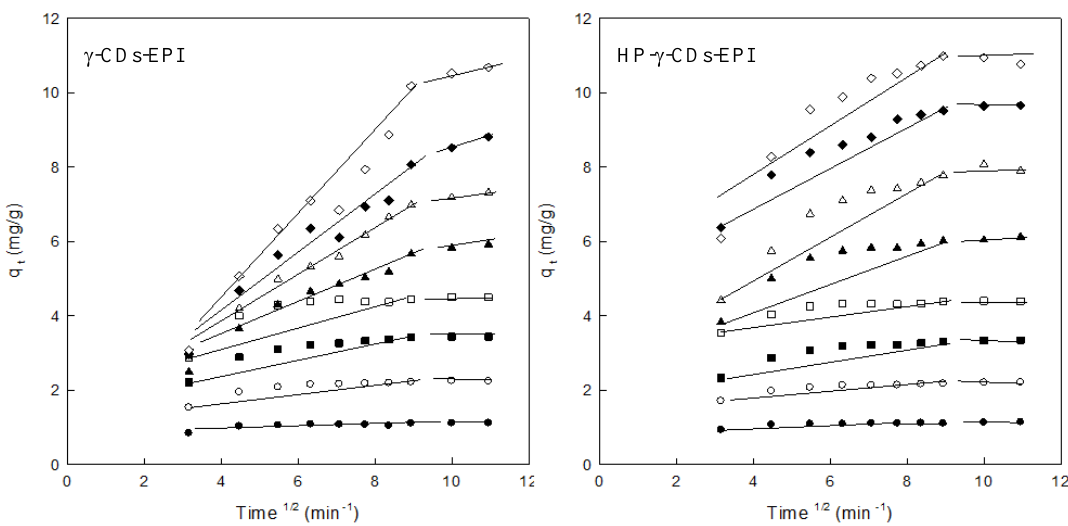
Figure 8. Intraparticle diffusion model analysis for both adsorbents and different DR concentrations (25 mg/L (●), 50 mg/L ( ○ ), 75 mg/L ( ■ ), 100 mg/L (□), 150 mg/L ( ▲ ), 200 mg/L (Δ), 250 mg/L ( ♦ ) and 300 mg/L ( ⟡ )). Experimental conditions: adsorbent = 1g, pH = 7, speed = 500 rpm, contact time = 120 min, dye concentration = 25–300 mg/L.